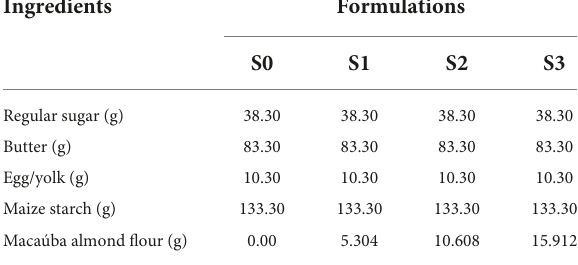
TABLE 1 Formulations of the sequilhos-type biscuits under different proportions of macaúba almond